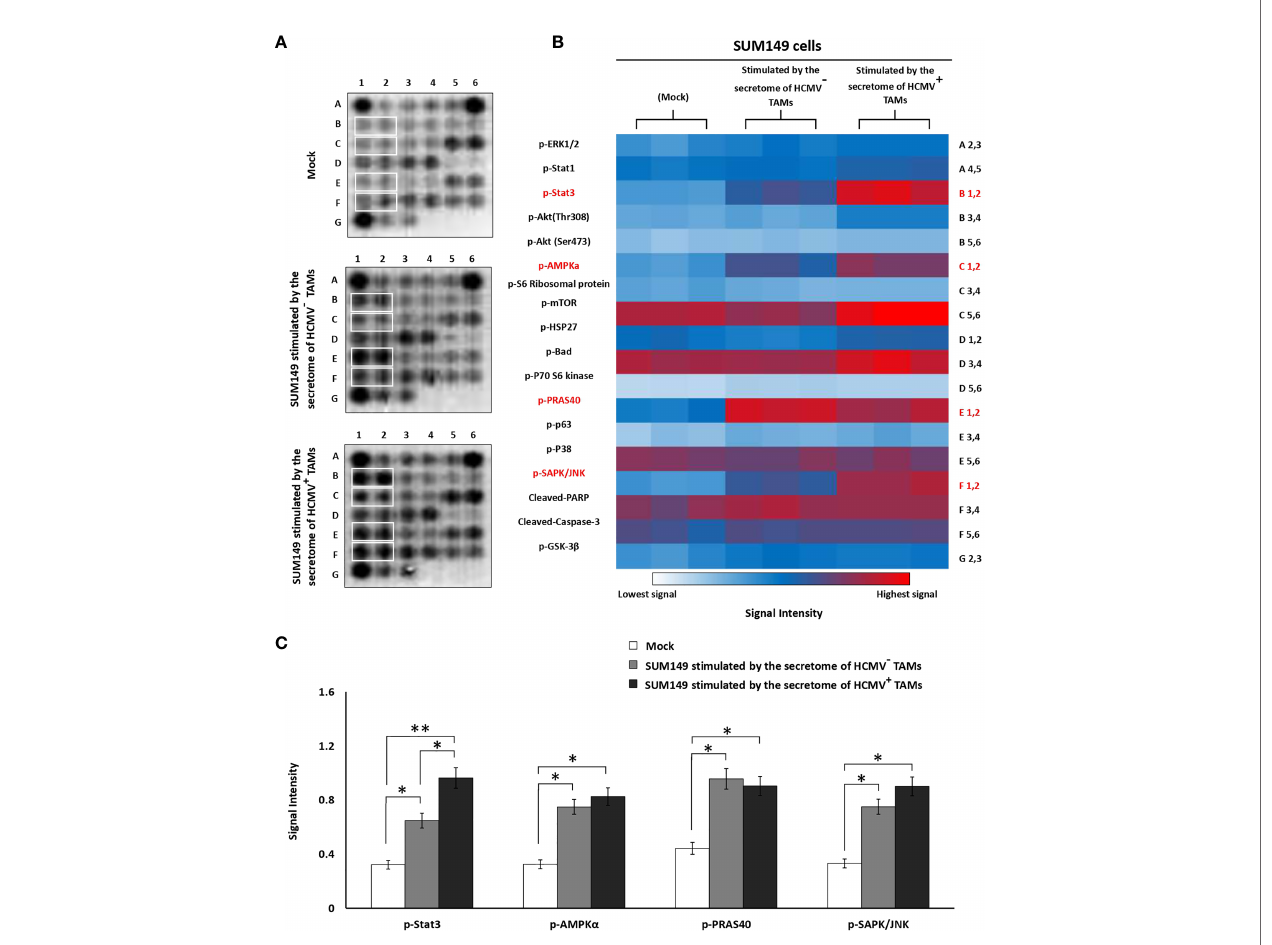
FIGURE 6 | Intracellular pathways array analysis of SUM149 cells stimulated by the secretome of HCMV - and HCMV + TAMs compared to mock cells. (A) PathScan ® intracellular array membranes of SUM149 cells stimulated by the secretome of HCMV - and HCMV + TAMs compared to mock cells. (B) Heat map showing the different activation levels of eighteen signaling molecules in SUM149 cells stimulated by the secretome of HCMV - and HCMV + TAMs compared to mock cells. (C) Bars represent a high expression of p-STAT3, p-AMPKa, p-PRAS40, and p-SAPK/JNK intracellular cell signaling molecules in SUM149 cells stimulated by the secretome of HCMV - and HCMV + TAMs compared to mock cells. * Represented ( P < 0.05) and ** represented ( P < 0.01) as determined by one-way ANOVA test followed by Tukey ’ s HSD and Post Hoc tests. Data represented as means ± SD (number of experimental replicates =